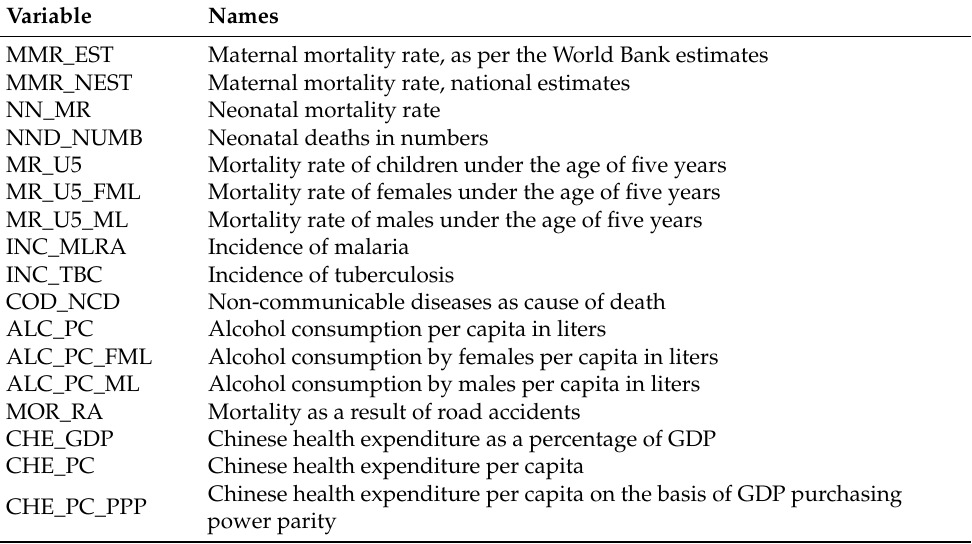
Table 1. Variable abbreviations and